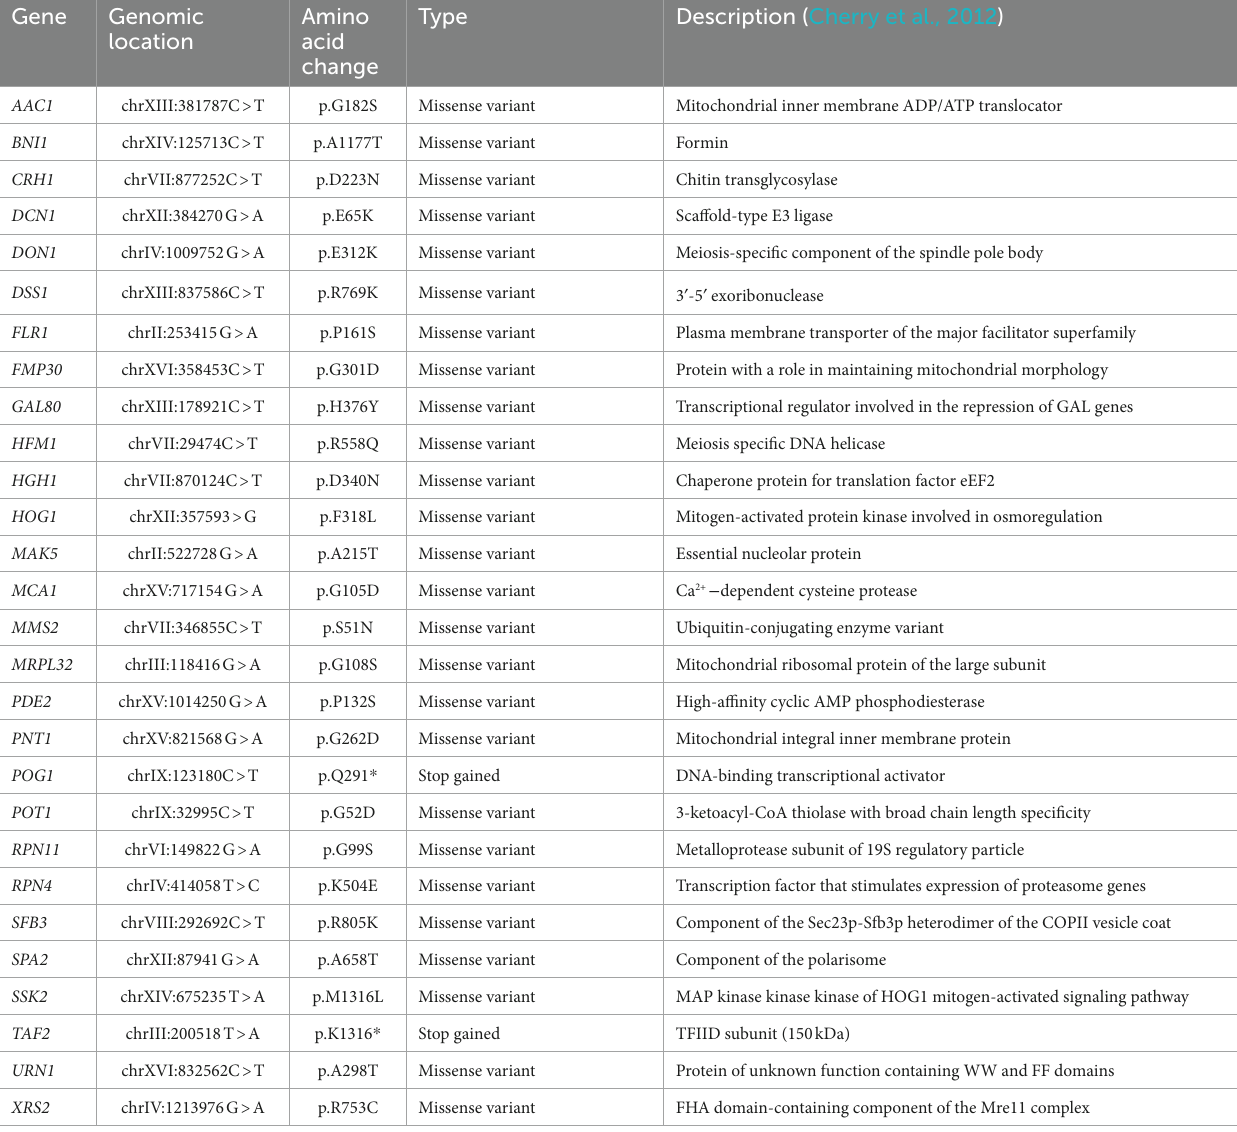
TABLE 1 The mutations detected in 2-phenylethanol-resistant mutant strain.